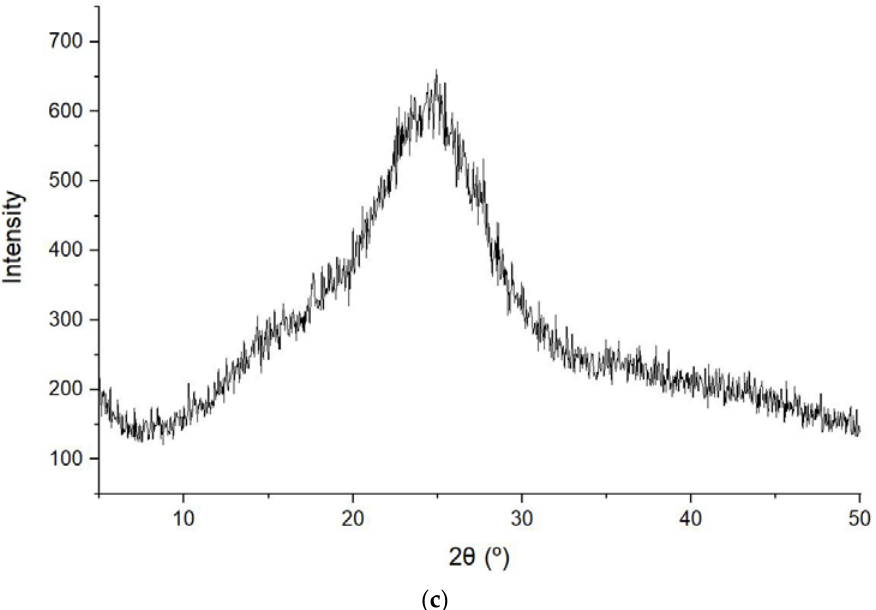
Figure 5. X-ray powder diffraction (XRPD) of different taxifolin forms at room temperature: ( a ) raw taxifolin; ( b ) taxifolin microtubes; ( c ) taxifolin microspheres.